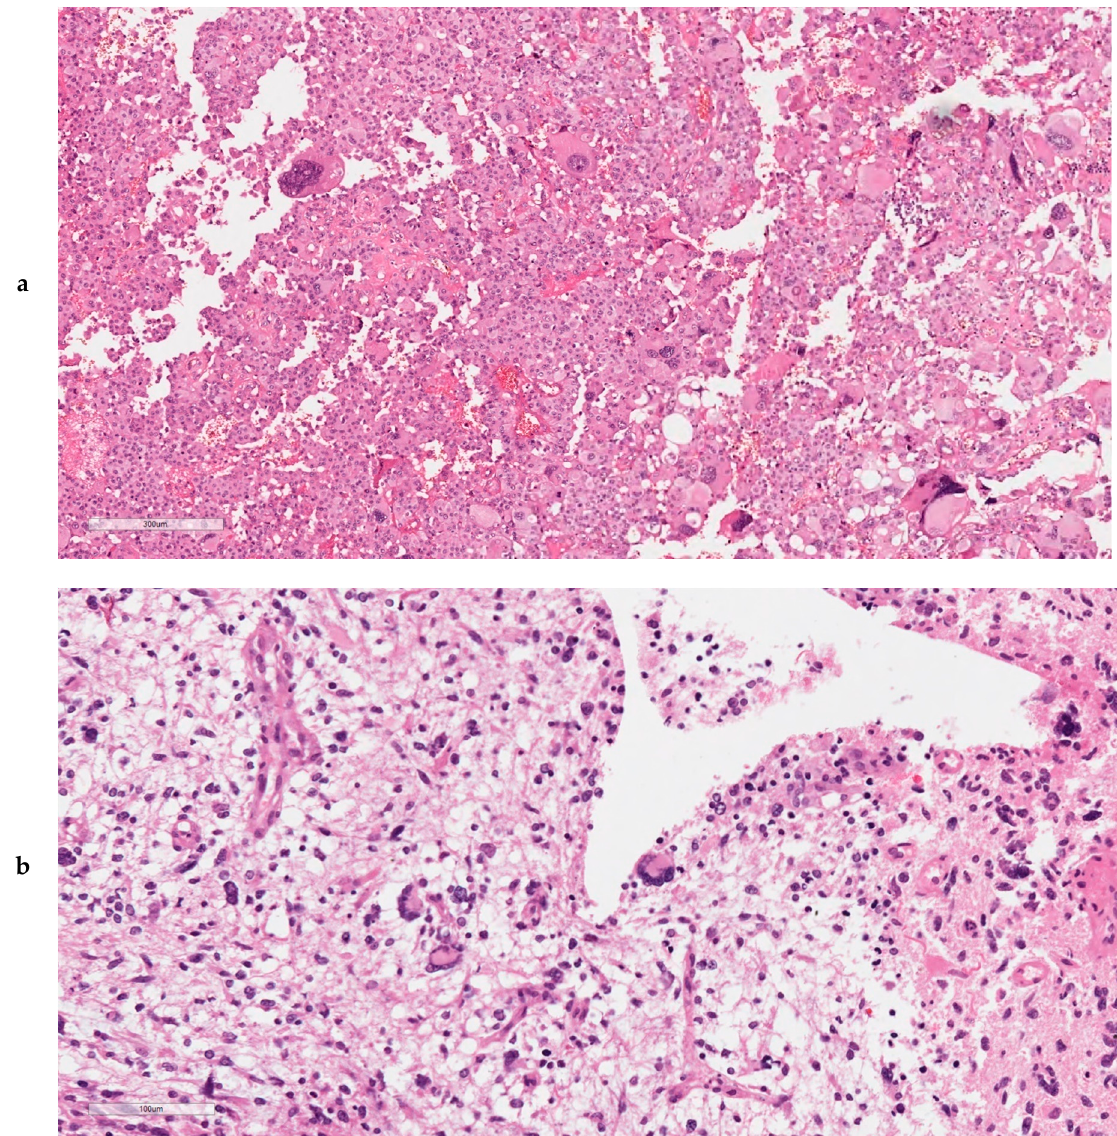
Figure 1. Histopathological aspects of ultra-mutated GBMs. Both cases 5 GL ( a ) and 12 GL ( b ) featured neoplastic giant cells bi- or multinucleated, which were uniformly dispersed throughout the tumour ( a , b : original magnification, 200×).